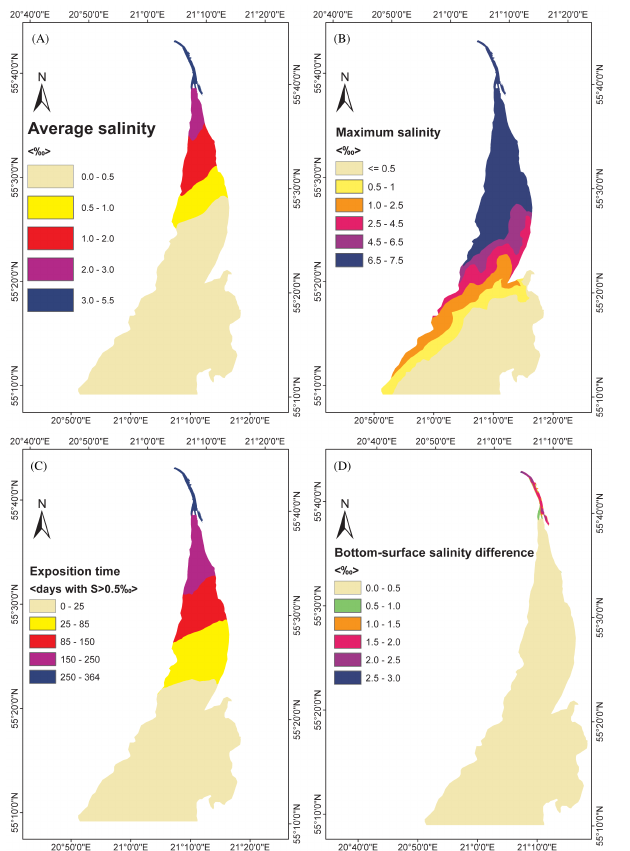
Fig. 5. Time series of (A) fresh water discharge into the lagoon, (B) wind speed vector azimuth in the northern part of the lagoon, (C) modelled water level in the open shelf in front of the lagoon (red dotted line) and in the northern part of the lagoon (blue continuous line), (D) modelled salt flux through cross-section S5 (blue band; positive value indicates flow toward lagoon and negative value indi- cates flux seawards) and depth averaged salinity in the northern part of the lagoon (black